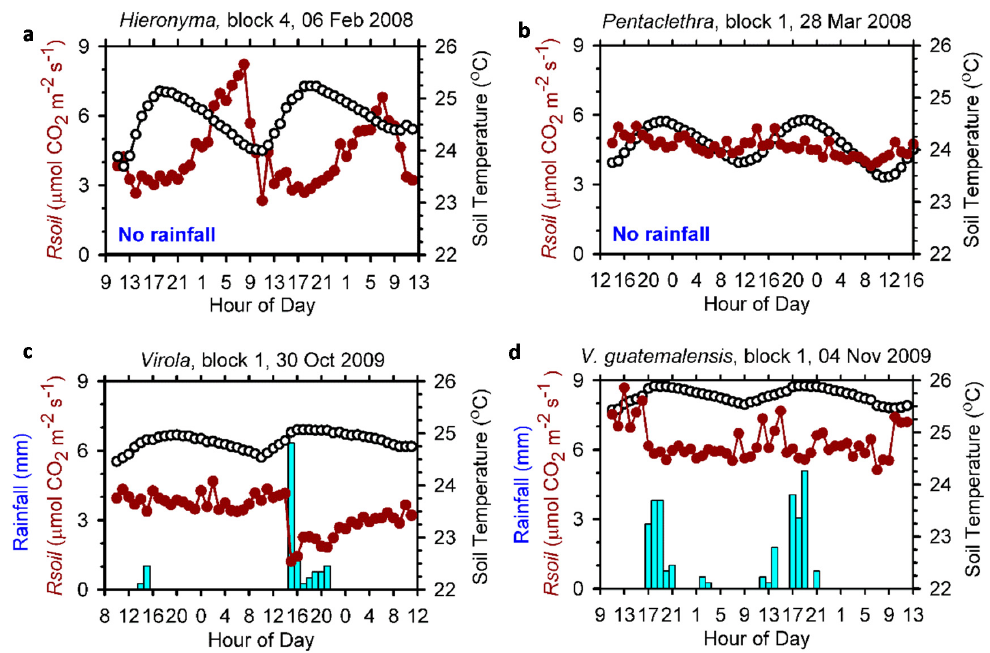
Figure 7. Soil temperatures at 10 ‐ cm depth (open symbols), soil respiration ( Rsoil , dark red symbols and lines) and hourly rainfall (blue bars) over 52 continuous hours on different dates in plantations of four different tree species at La Selva. Dates refer to the beginning of the measurement period.